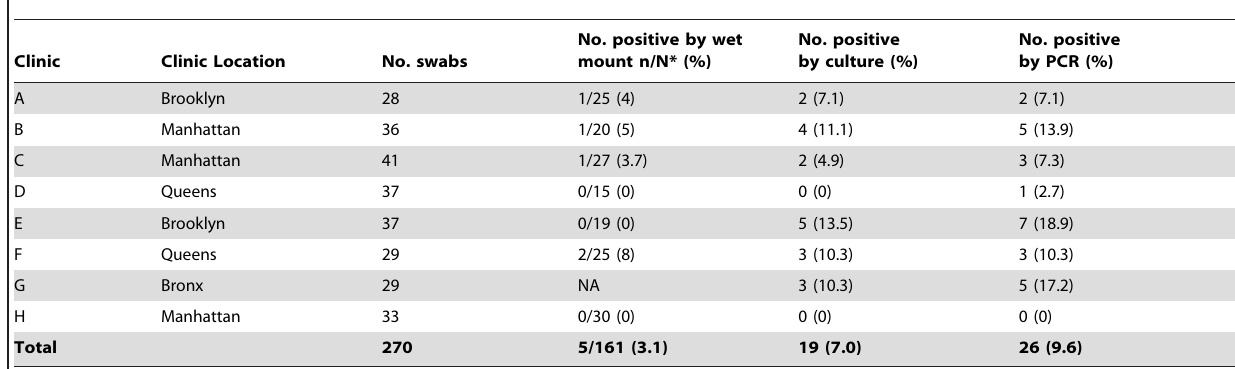
Table 1. Prevalence of T. vaginalis in women attending New York City STD clinics.